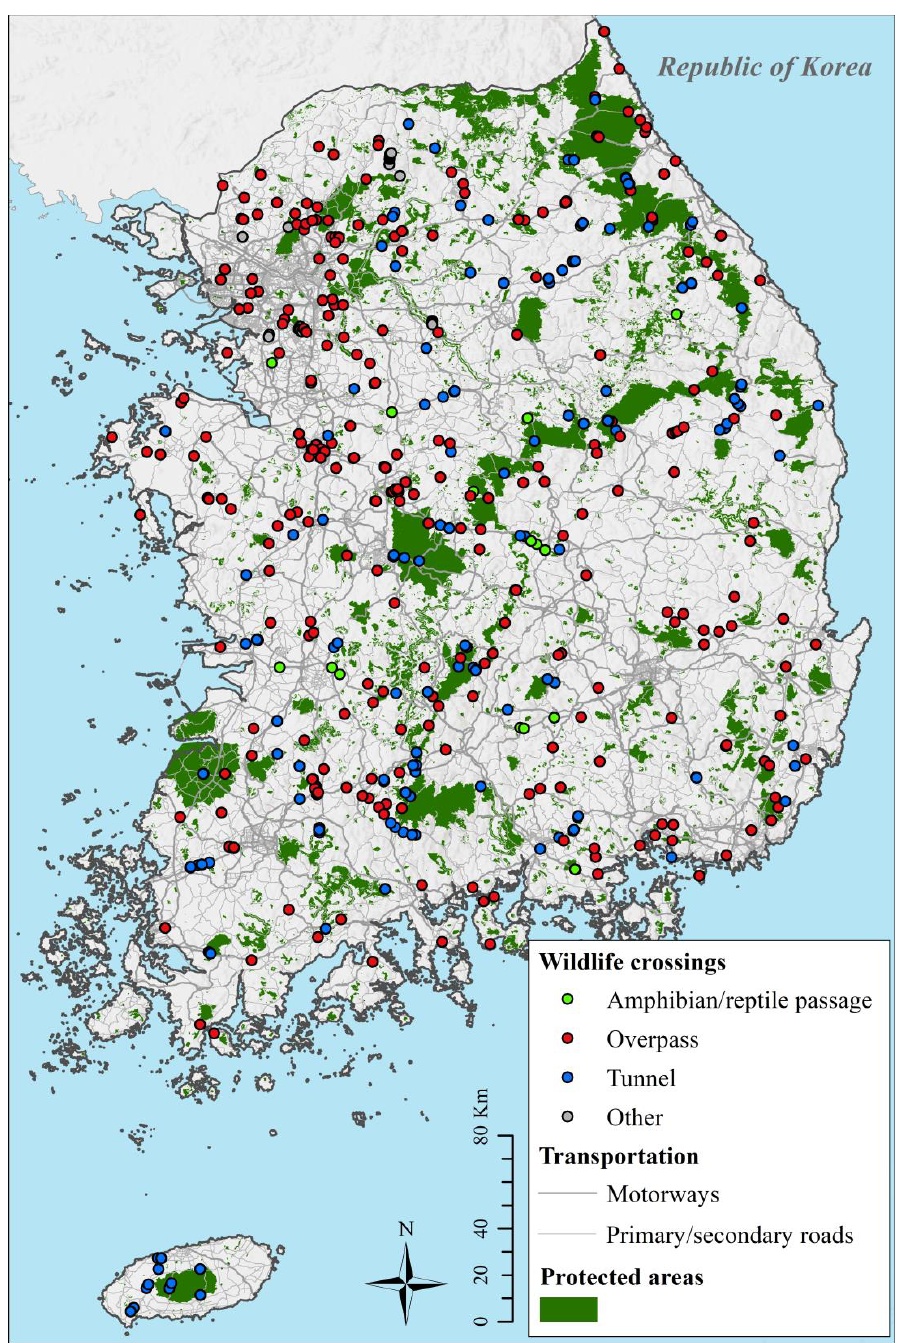
Figure 1. Map of the Republic of Korea with wildlife crossings and transportation. Wildlife crossing data provided by the National Institute of Ecology Korea (NIEK; available at: https://www.nie-ecobank.kr/wildlifecrossing/mapservice/MapserviceList.do (accessed on 6 July 2021)). Transportation data provided by OpenStreetMap contributors [65] (available at: https://www.openstreetmap.org (accessed on 16 July 2021)). Protected areas downloaded from Protected Planet [17] (www.protectedplanet.net (accessed on 10 May 2021)).